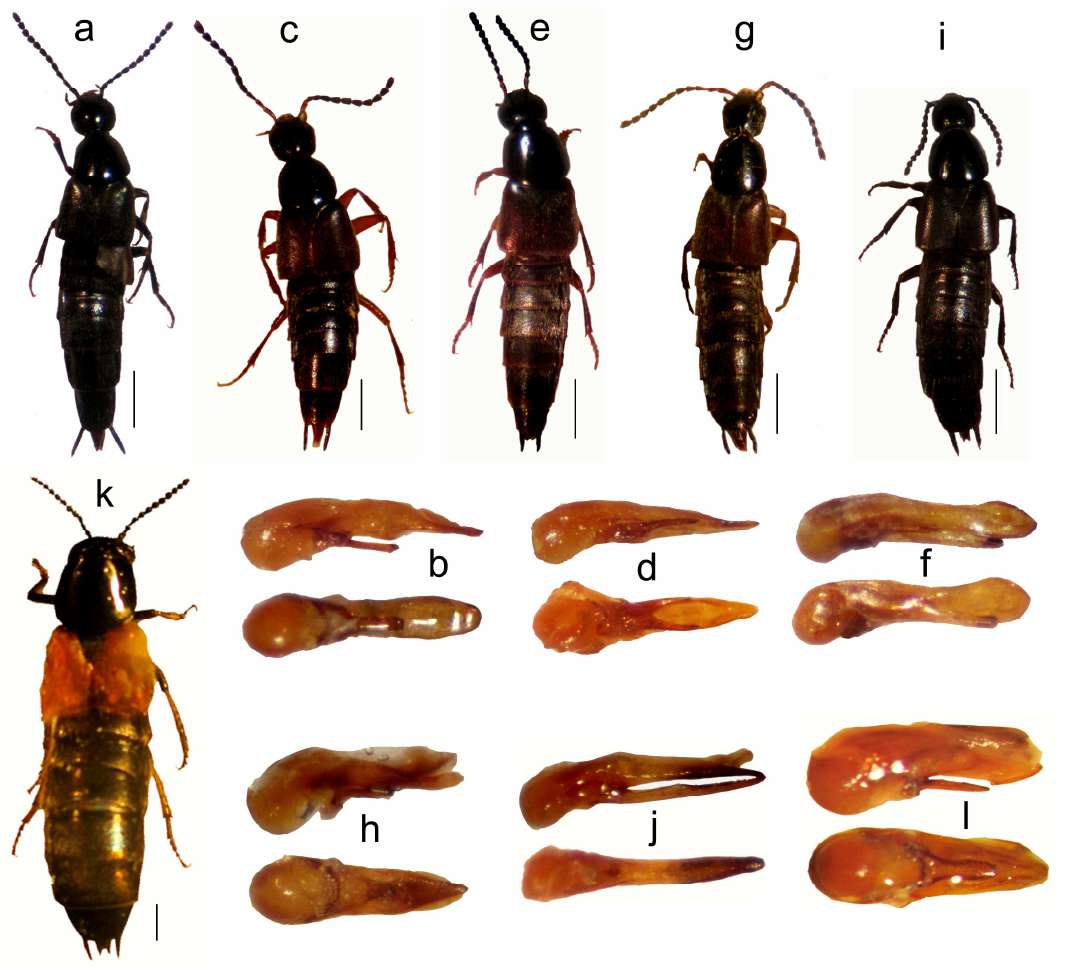
F IGURE 1. a-b) Philonthus juvenilis , c-d) Philonthus micans , e-f) Philonthus longicornis , g-h) Philonthus viridipennis , i-j) Philonthus wuesthoffi , k-l) Philonthus spinipes ; a, c, e, g, i and k) dorsal habitus, b, d, f, h, j, and l) aedeagus in lateral and ventral views, Scale bars: 1